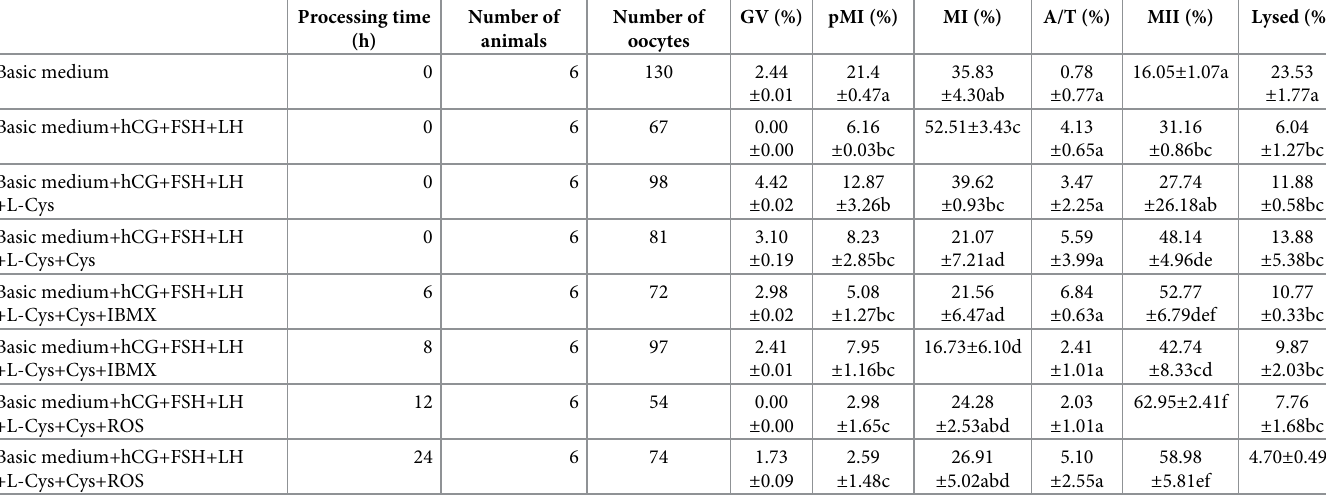
Table 5. Effects of different amino acids and inhibitors on the IVM rate of guinea pig